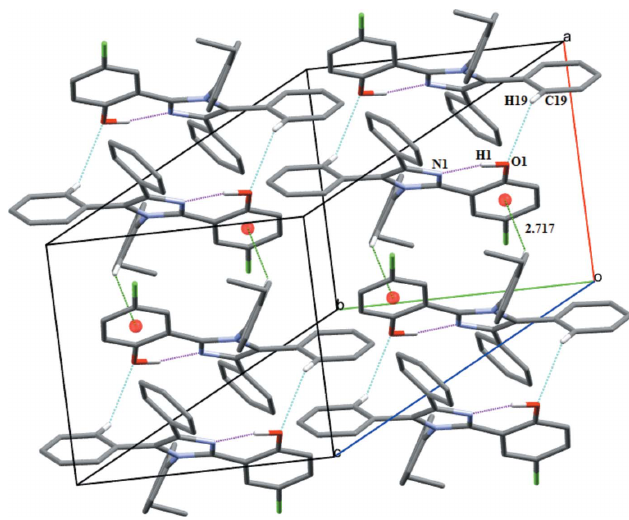
Figure 2 Unit-cell packing of the title compound showing the intramolecular O— H (cid:3)(cid:3)(cid:3) N interactions, intermolecular C—H (cid:3)(cid:3)(cid:3) O interactions and inter- molecular C—H (cid:3)(cid:3)(cid:3) (cid:2) interactions as dotted lines. H atoms not involved in hydrogen bonding have been